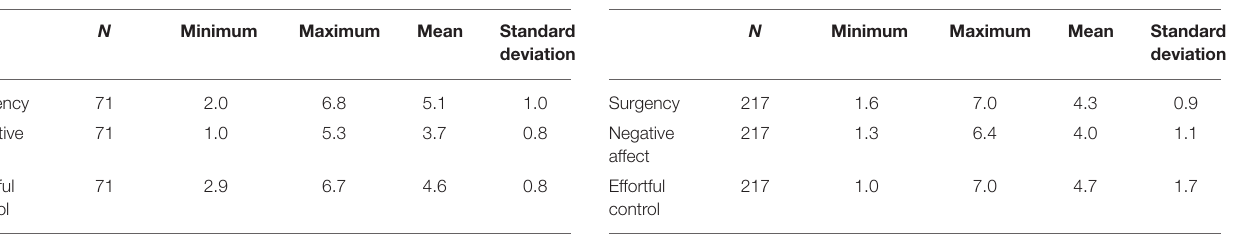
TABLE 3 | Behavior scores for children aged 18–36 months. TABLE 4 | Behavior scores for children aged 3–5